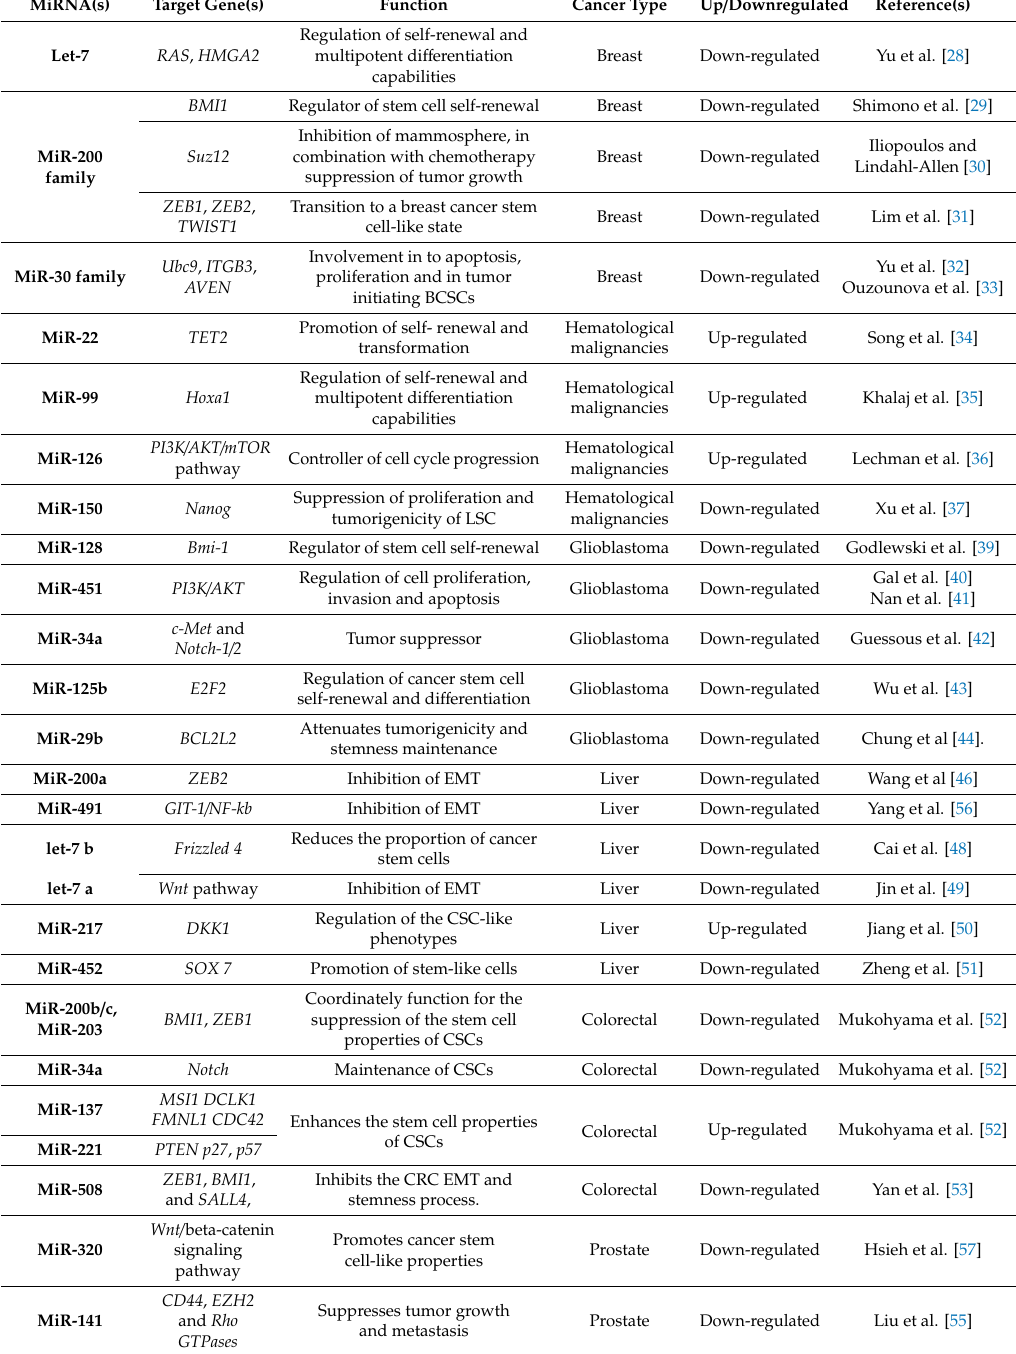
Table 1. Function of up / downregulated microRNA (miRNAs) in di ff erent types of cancer stem cells and their molecular